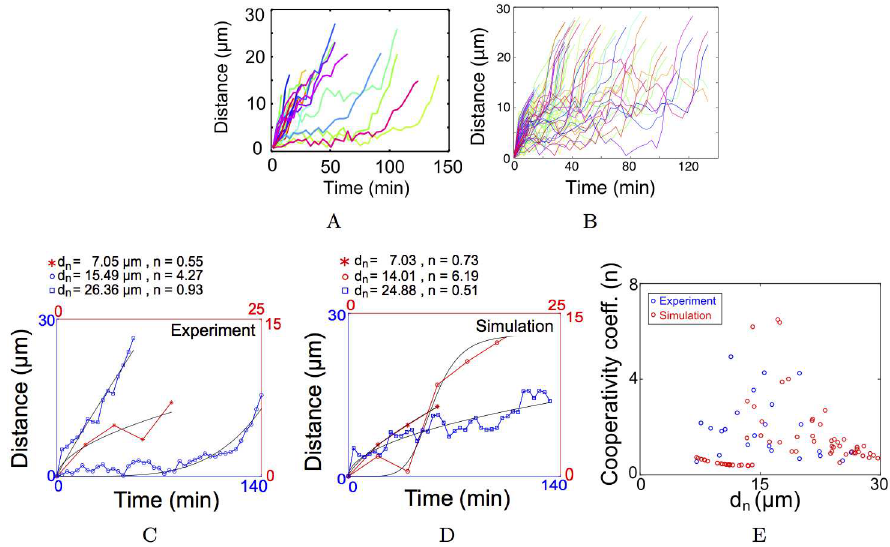
Fig 2. Distance travelled by MTOCs in experiment and simulation. The distance travelled from the site of nucleationis plotted as a function of time from (A) experimentand (B) optimizedRWD gradient model. Colors indicate individualtracks. Representative fits (black line) to Eq 11 of data from (C) experimentand (D) simulation. Blue and red indicate the axes which scale the respective distance-time graphs. d n is the distance from chromatin where the MTOC is nucleatedand n is the cooperativity coefficient from the fit. (E) The fit values of n from experiment (blue) and simulation(red) are plotted as a function of d n . The goodnessof fit R 2 > 0.7 for all